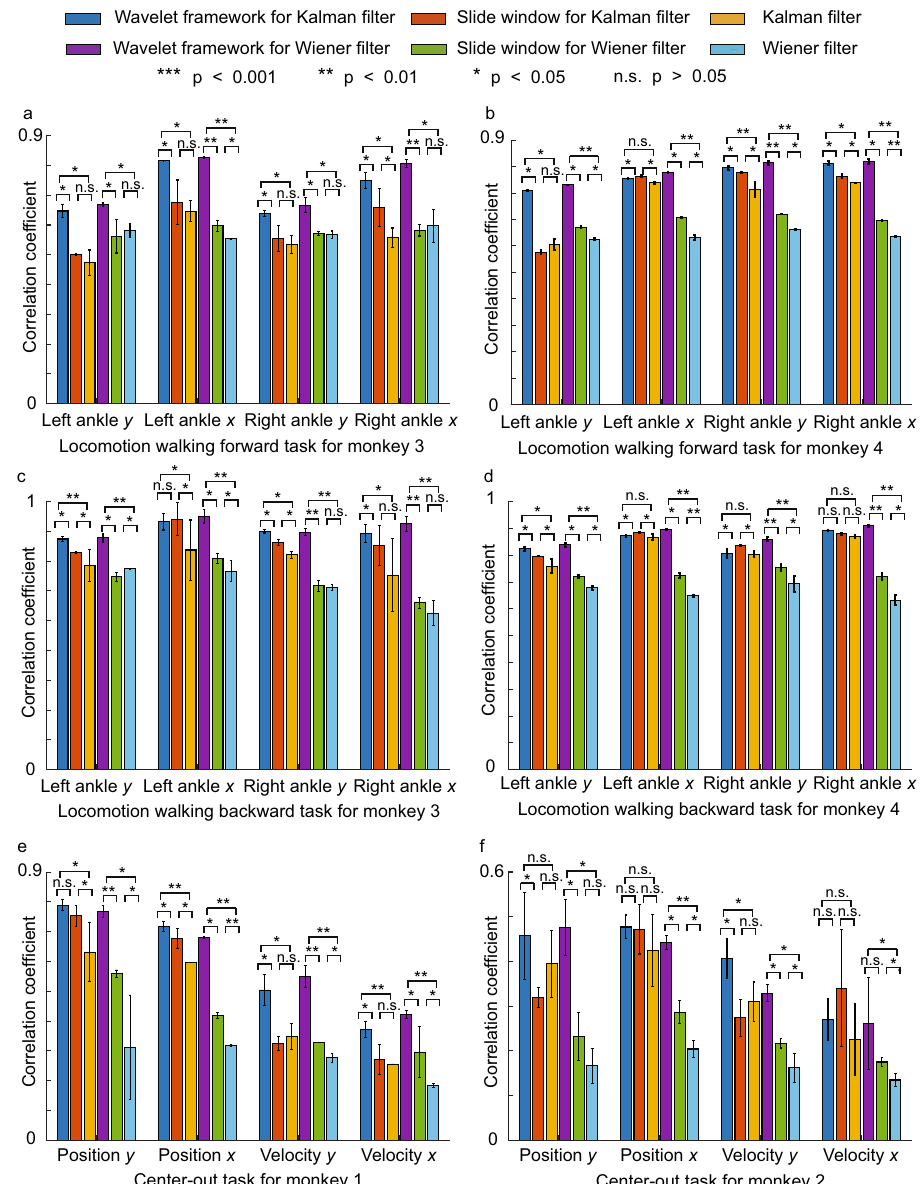
Figure 5. Decoding performance for locomotion tasks and center-out tasks measured by correlation coefficient between decoded covariates and ground truths in 5-fold cross-validation (mean + / − S.D., n = 5 folds). We use Wilcoxon signed-rank test to validate the results. ( a ) Locomotion walking forward task for Monkey 3. ( b ) Locomotion walking forward task for Monkey 4. ( c ) Locomotion walking backward task for Monkey 3. ( d ) Locomotion walking backward task for Monkey 4. ( e ) Center-out task for Monkey 1. ( f ) Center-out task for Monkey